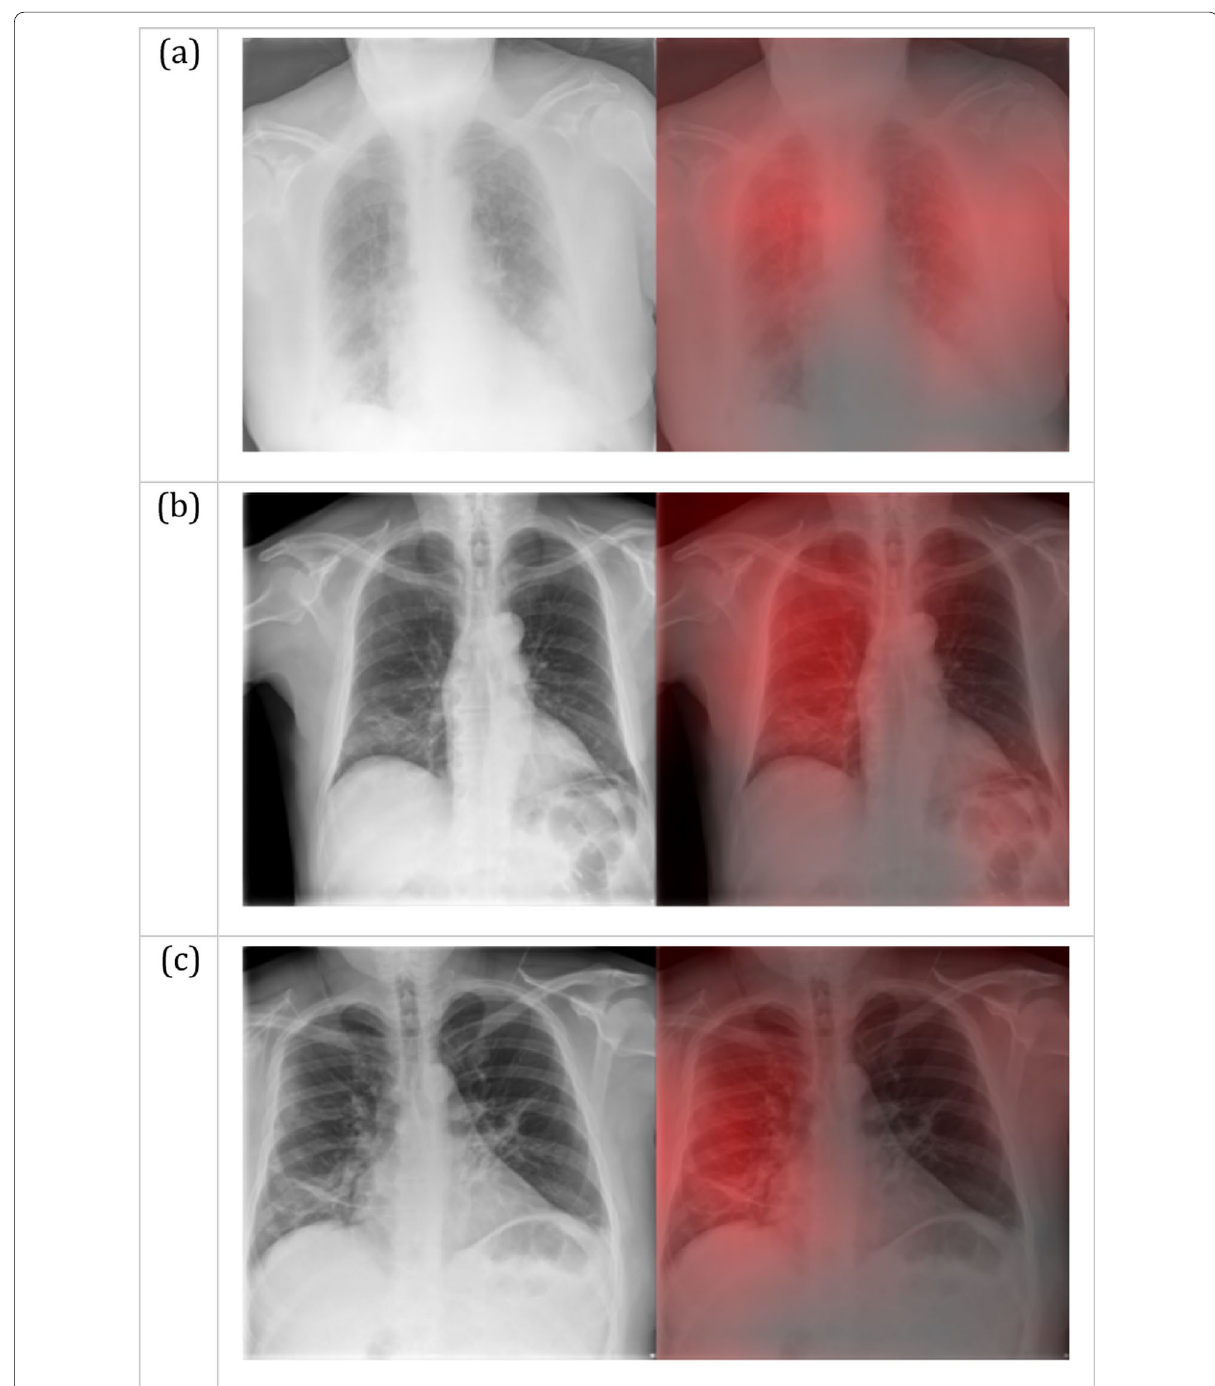
Fig. 2 Grad‑CAM heatmaps for True Positive COVID‑19 predictions. The red intensity on the right images indicates the image regions that are important for the positive prediction. These regions correspond to patchy consolidations and ground‑glass opacities, with a peripheral, bilateral distribution ( a ) or a mid and lower zone predominance on the right lung ( b , c